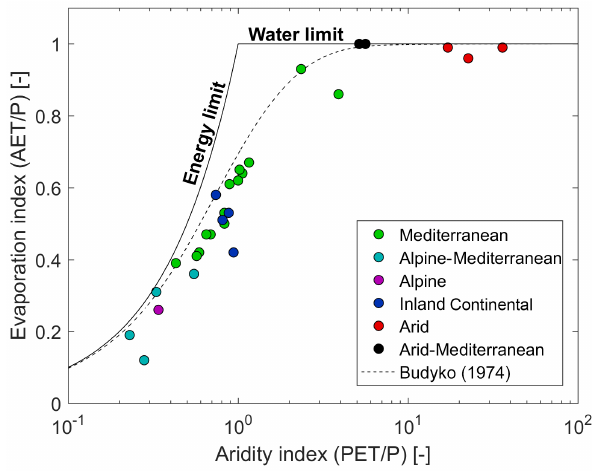
Figure 2. Budyko plot for the study basins ( P : mean annual precip- itation, AET: mean annual actual evapotranspiration, PET: mean an- nual potential evapotranspiration). In case of multiple nested catch- ments, only data for the largest one are